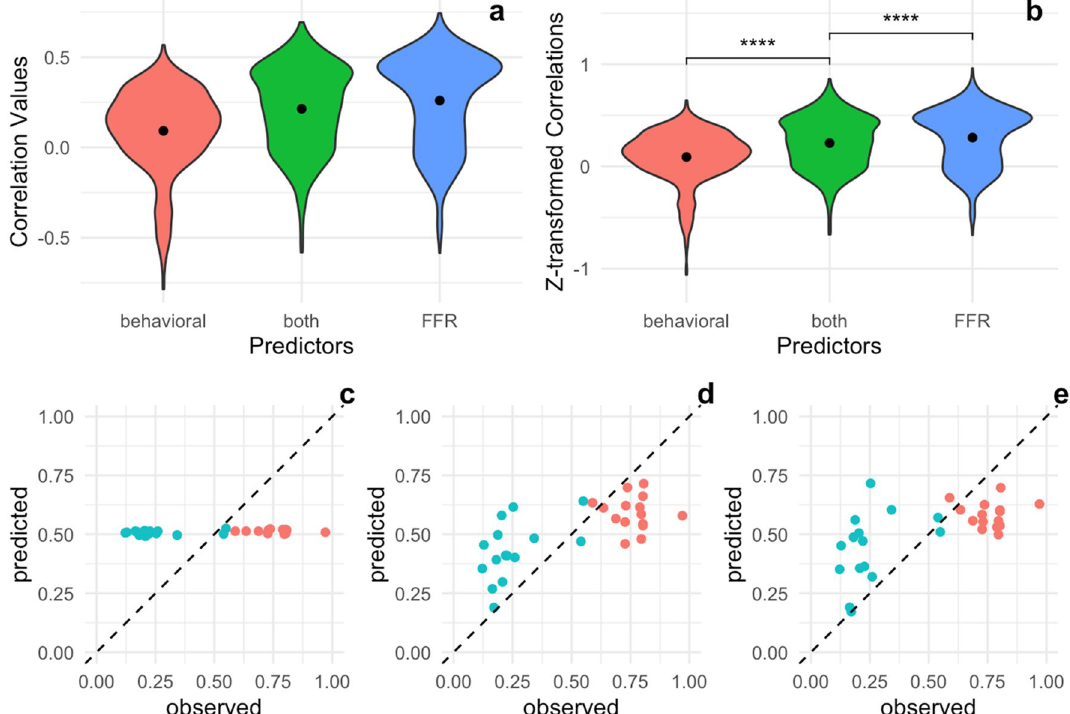
Figure 5. Predictive Performance of Behavioral Tests, Piano FFR, and a Combined Model on Pitch Labelling Performance. ( a , b ) Correlation between the predicted pitch labelling performances and the true pitch labelling performances on a test set are shown for 1000 cross-validation runs. The FFR to the piano tone predicts pitch labelling performance better than the behavioral tests as well as the combined model. ( c ) Predicted pitch labelling performance based on the behavioral tests plotted against actual, observed pitch labelling performance. Red dots represent subjects who self-reported as AP possessors. ( d ) Predicted pitch labelling performance based on a combined model of both behavioral tests and the piano FFR plotted against observed pitch labelling performance. Red dots represent subjects who self-reported as AP possessors. ( e ) Predicted pitch labelling performance based on the piano FFR plotted against observed pitch labelling performance. Red dots represent subjects who self-reported as AP